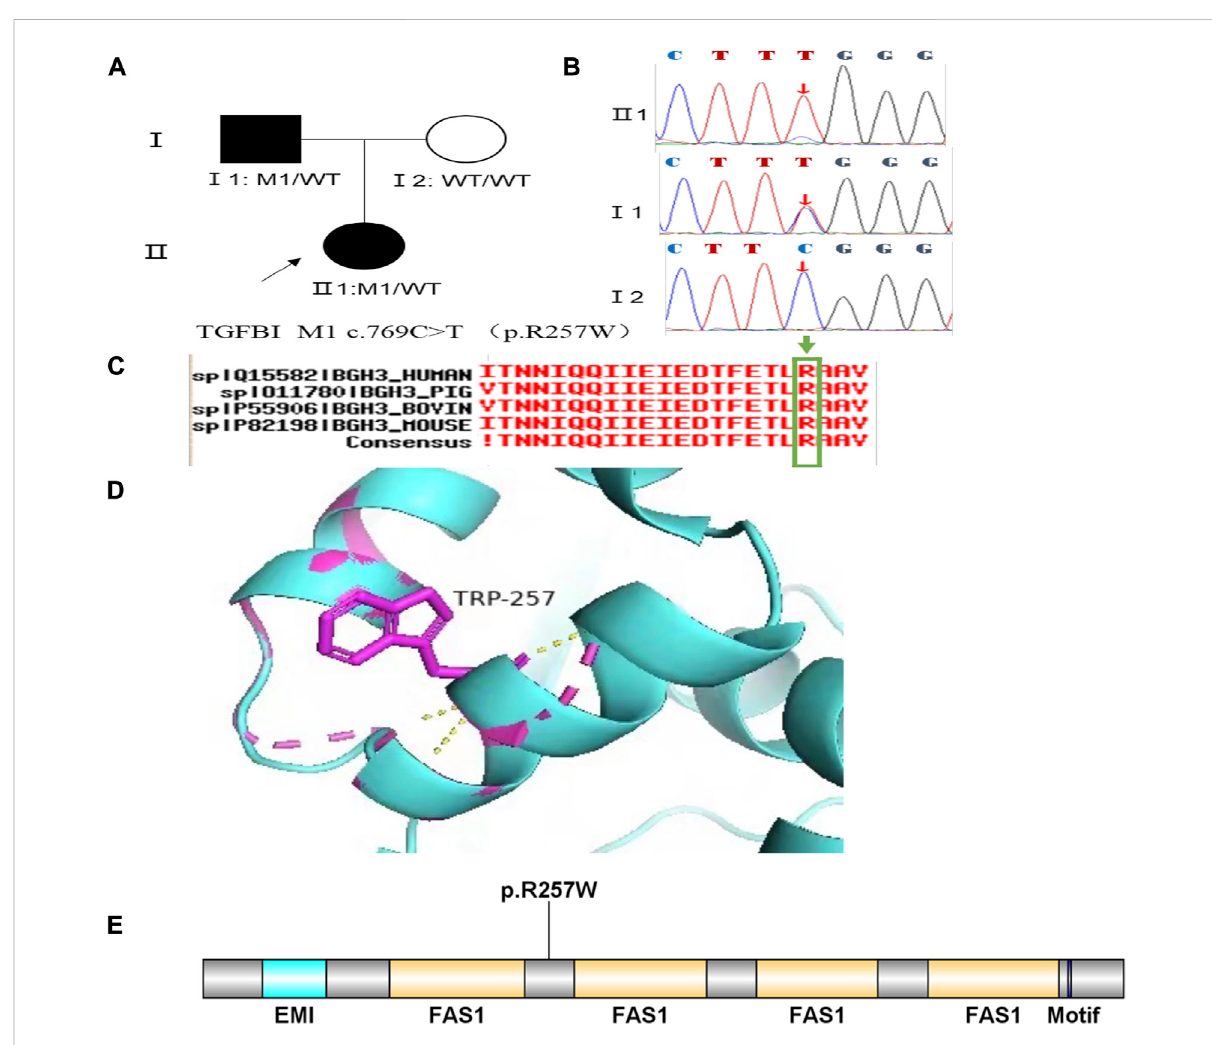
FIGURE 4 Sequence analysis and identi fi cation of the variant of TGFB1 in the affected Chinese family with autosomal-dominant KC. (A) Pedigree of the family. The fi lled black symbols represent the affected members, and the arrow denotes the proband. (B) By sequencing analysis, a heterozygous variantof (C) 769C > Twasidenti fi edintheaffectedindividualsofII:1andI:1. (C) ThehomologyofaminoacidsequencesbetweenhumanTGFB1and otherspecies.Theaminoacidatposition257(Arginine,R257)ishighlyconservedamongspecies(greenbox). (D) HomologymodeloftheTGF- β induced protein (green). Purple indicates the location of p. Arg257Trp in the protein structure. (E) Structural modelling of TGF - β induced protein